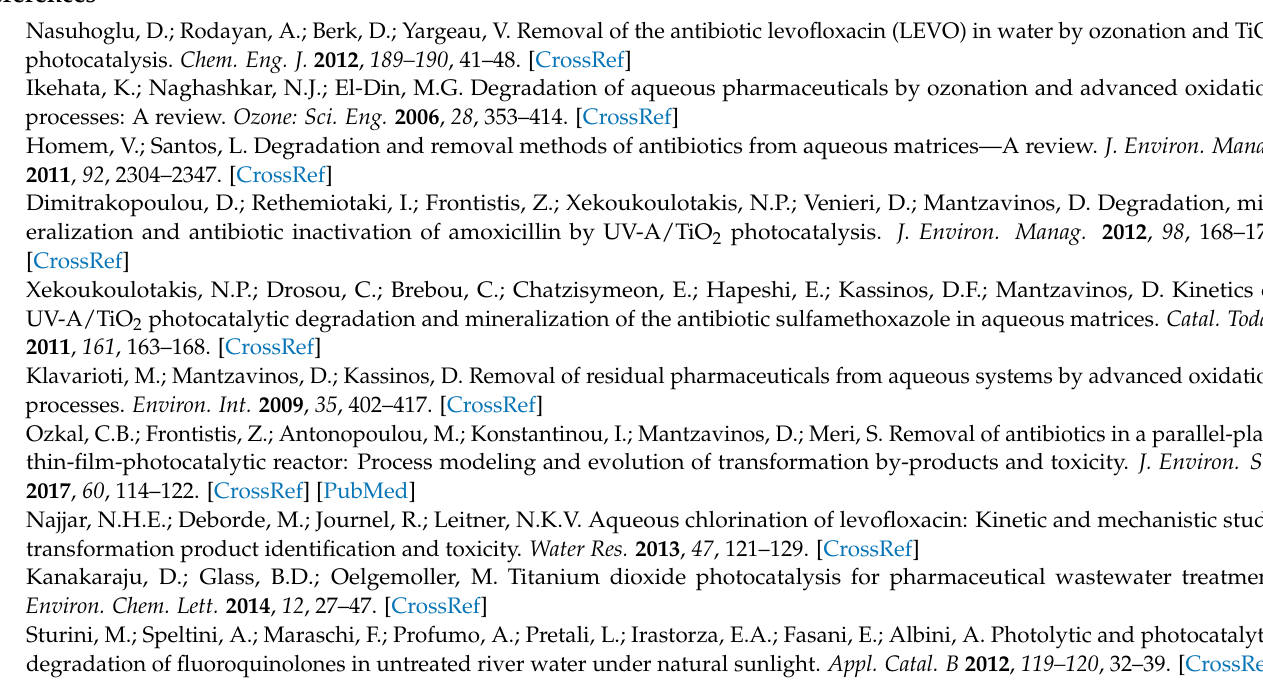
Figure S2: (a) Variation of adsorption capacity of the prepared rGO-WO3 heterostructure with respect to temperature and (b) Van’t Hoff plot for the adsorption of LVX over rGO-WO3 heterostructure; Figure S3: (a) Langmuir, (b) Freundlich, (c) Redlich-Peterson and (d) Jossen adsorption isotherms for LVX adsorption onto rGO-WO3 heterostructure; Figure S4: Adsorptive removal efficiency of rGO-WO3 heterostructure in real water system spiked with LVX; Figure S5: (a,b) FESEM images of the reused rGO-WO3